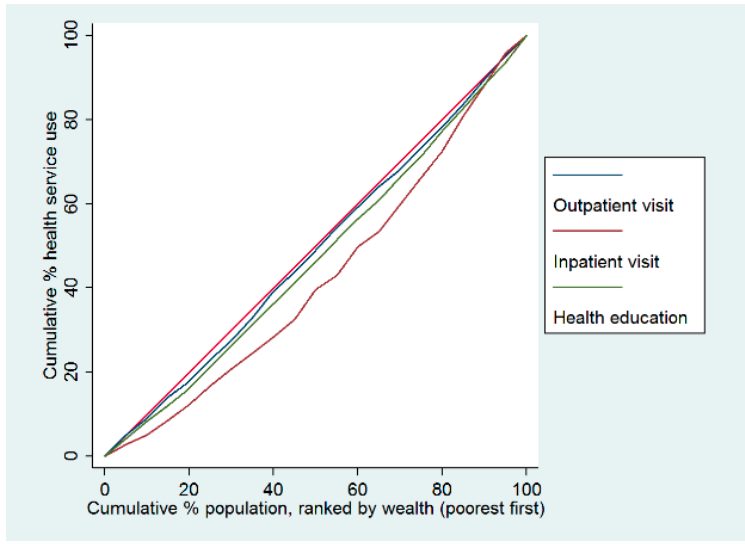
Figure 2. Concentration curves of health service use for adults with hypertension in China in 2015.